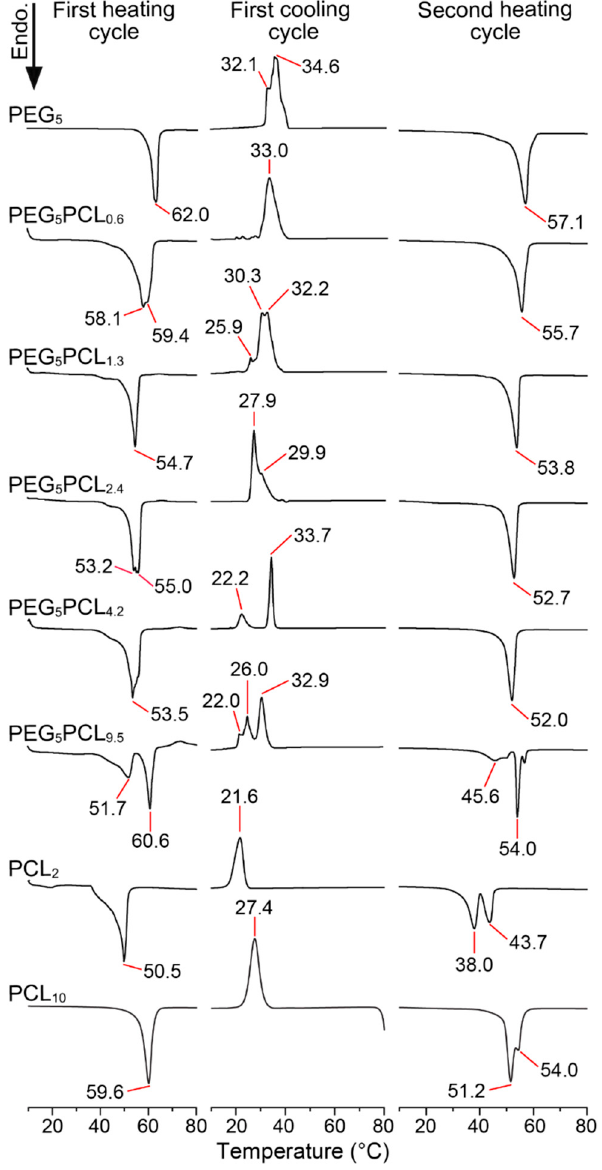
Figure 5. Representative DSC thermograms of the PEG 5 and PCL homopolymers and the PEG 5 PCL y polymer series, showing the first heating, first cooling, and second heating profiles (ramp rate 10 °C/min).